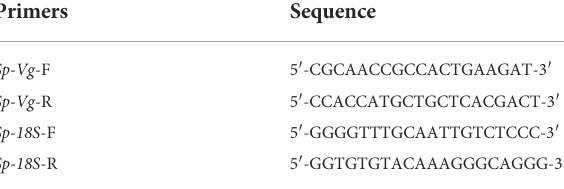
TABLE 2 The primer sequences for RT-qPCR used in this